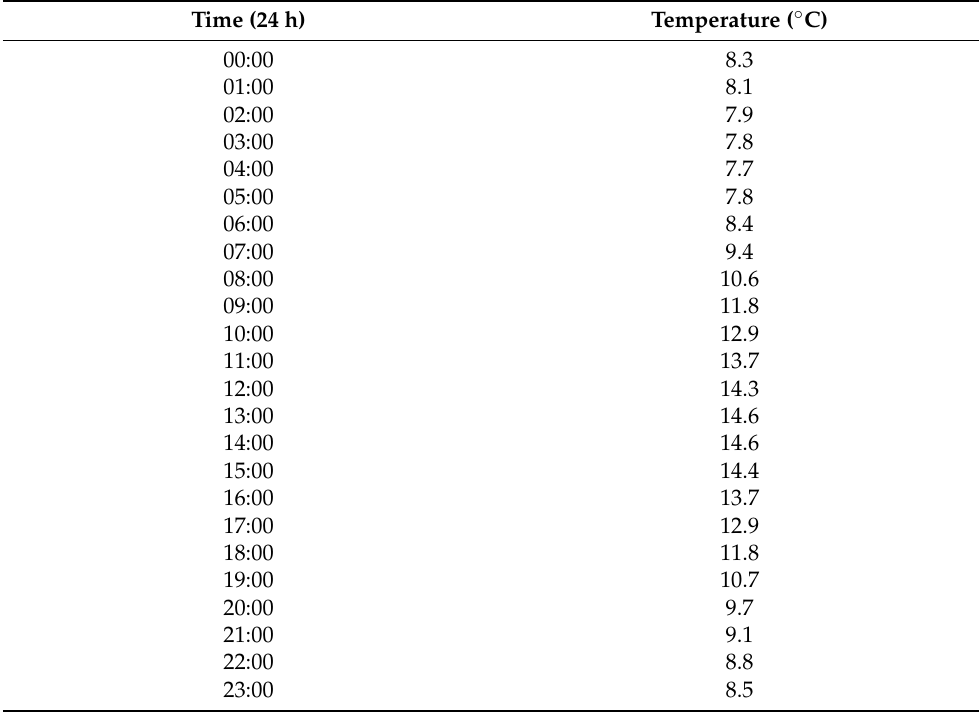
Figure 2. Sphagnum samples within the controlled environment chamber. Groups were kept within separate trays with samples rotated regularly during the measurement period. Table 4. Temperature Dataset Used Within the Controlled Environment Chamber.